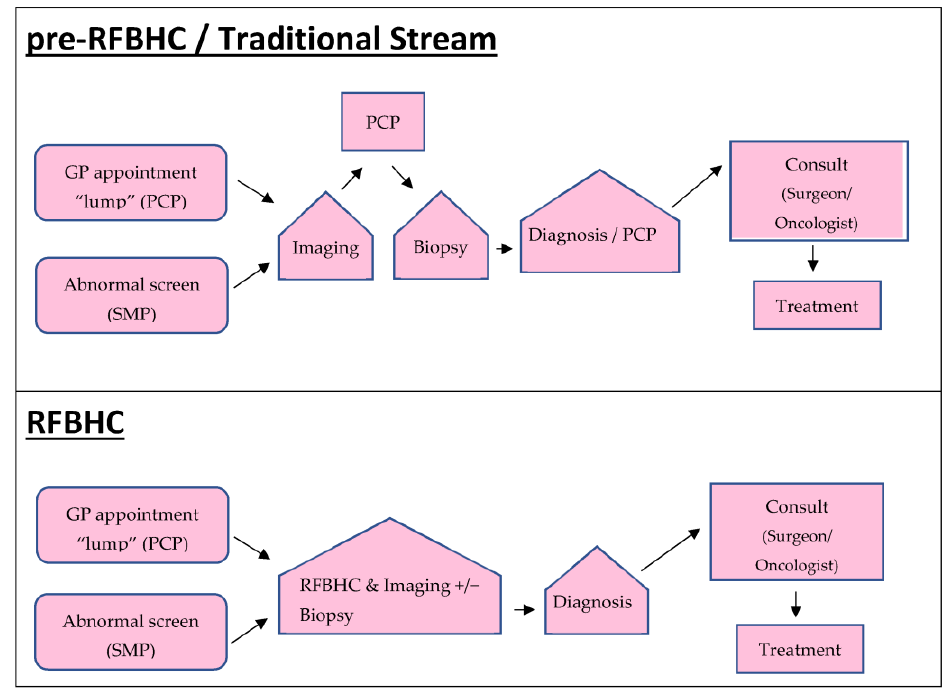
Figure 1. Diagnostic pathways. Pre-RFBHC patients were diagnosed with breast cancer prior to the establishment of the RFBHC (i.e., 1 January 2015 to 30 May 2017). RFBHC and Traditional Stream patients were diagnosed 30 May 2017 to 30 April 2019.